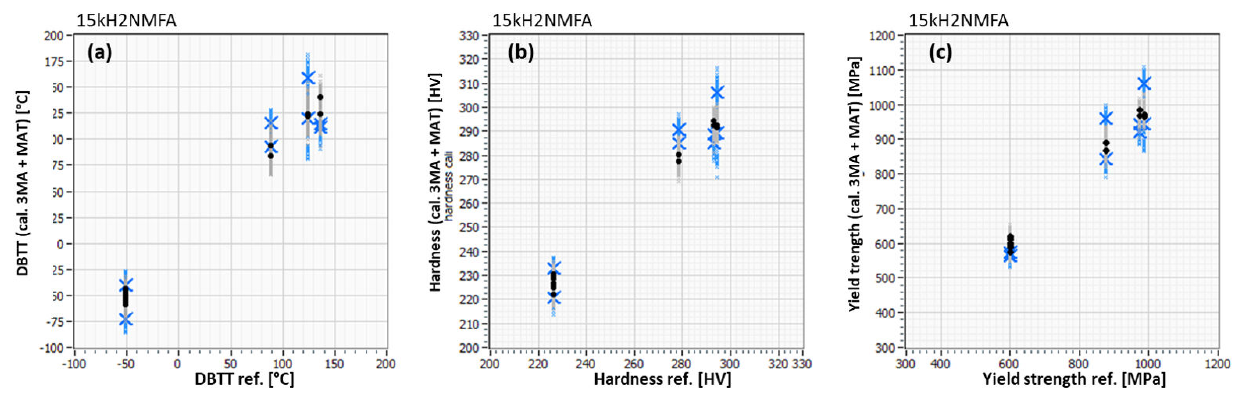
Figure 18. Results of the calibration procedure to predict DBTT ( a ), mechanical hardness ( b ), and yield strength ( c ) for